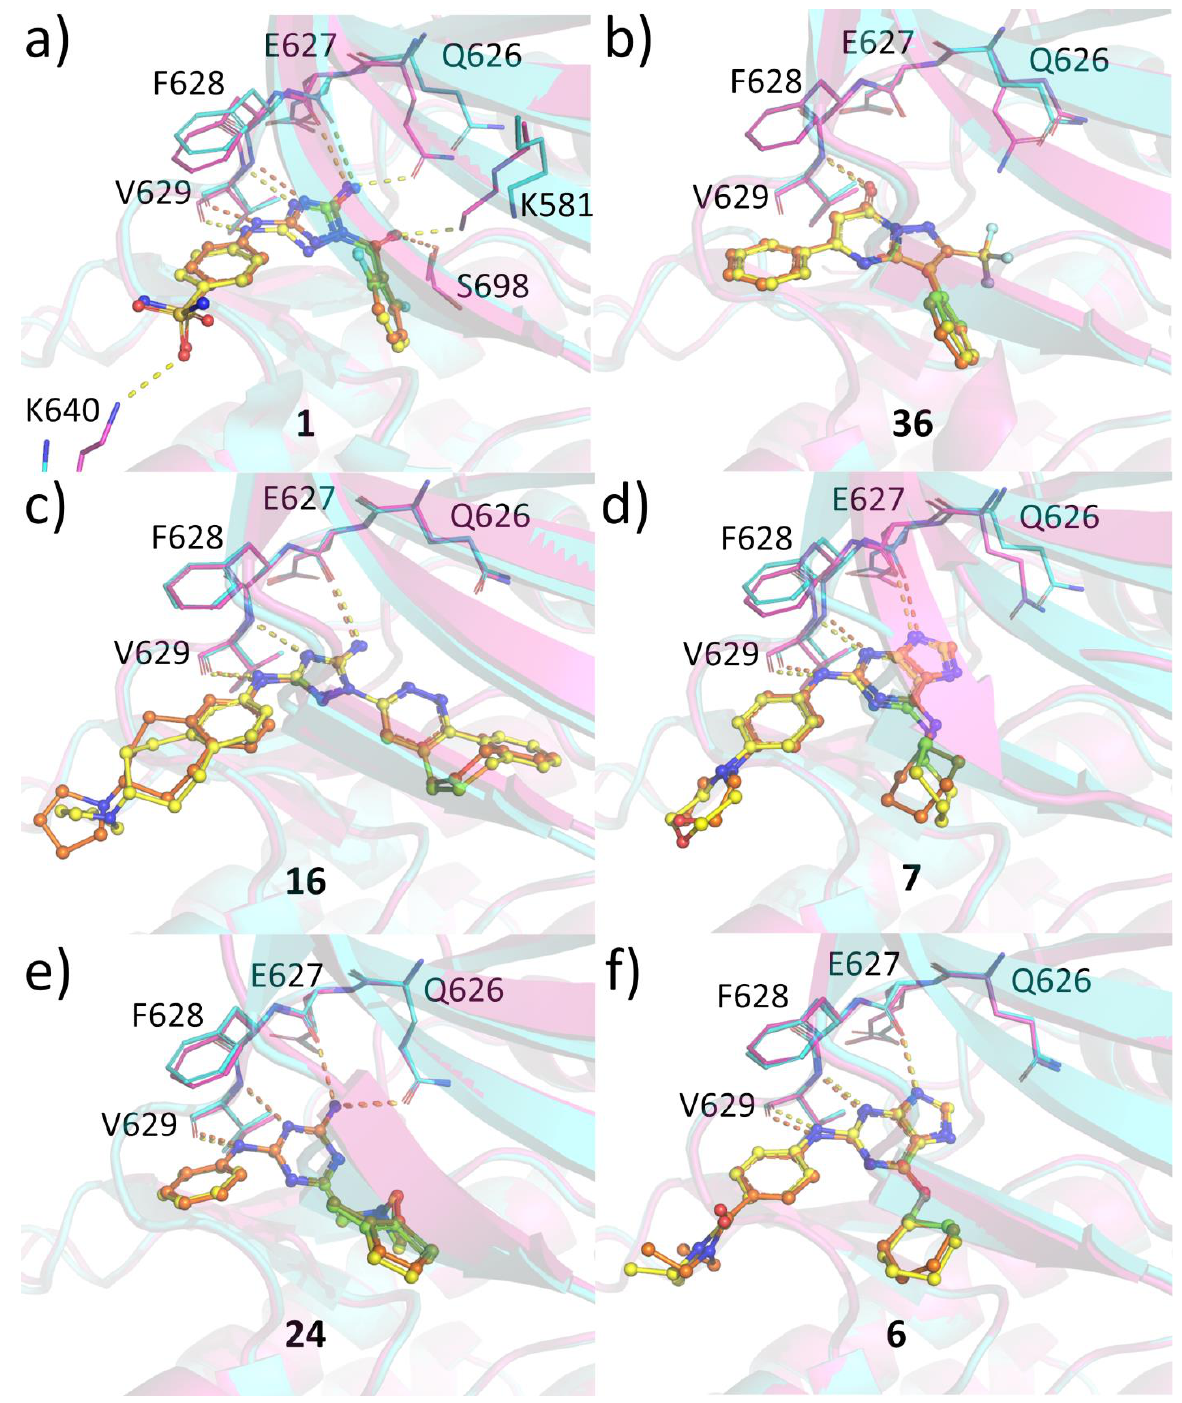
Figure 4. Crystal structures of selected hits and hits analogs with JAK2 JH2 wild-type and V617F mutant. The residues participating in hydrogen bonding and the gatekeeper Gln626 are shown as sticks. The ligand complexes of WT and V617F are superposed together. ( a ) Compound 1 (RMSD for aligned Cα atoms: 0.43). ( b ) Compound 36 (RMSD for aligned Cα atoms: 0.133). ( c ) Compound 16 (RMSD for aligned Cα atoms: 0.371). ( d ) Compound 7 (RMSD for aligned Cα atoms: 0.378) . ( e ) Compound 24 (RMSD for aligned Cα atoms: 0.243). ( f ) Compound 6 (RMSD for aligned Cα atoms: 0.43). For JAK2 JH2 WT, the structure is shown in turquoise, the ligand and hydrogen bonds in orange. For JAK2 JH2 V617F, the structure is shown in magenta, the ligand and hydrogen bonds in yellow. JAK2 JH2— 1 complex structure has been determined previously (pdb code